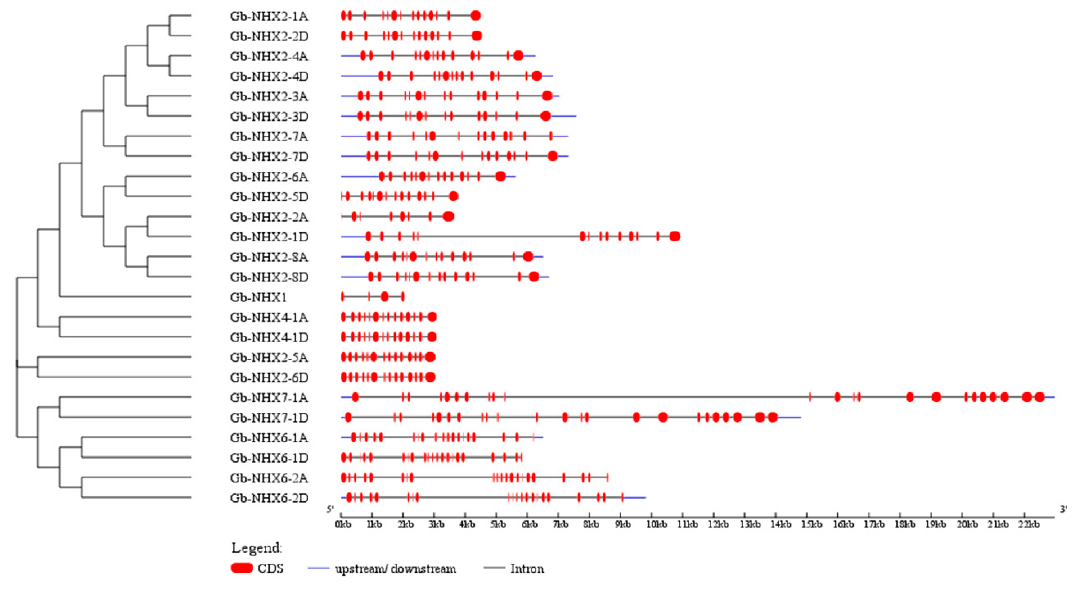
aa: amino acid; pI: isoelectric point; MW: molecular weight; Vac: vacuole; Pm: plasma membrane; Endo: endomembrane.